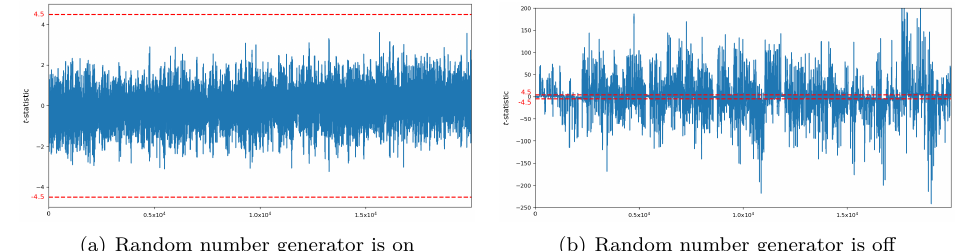
Figure 11: Security order d = 2.